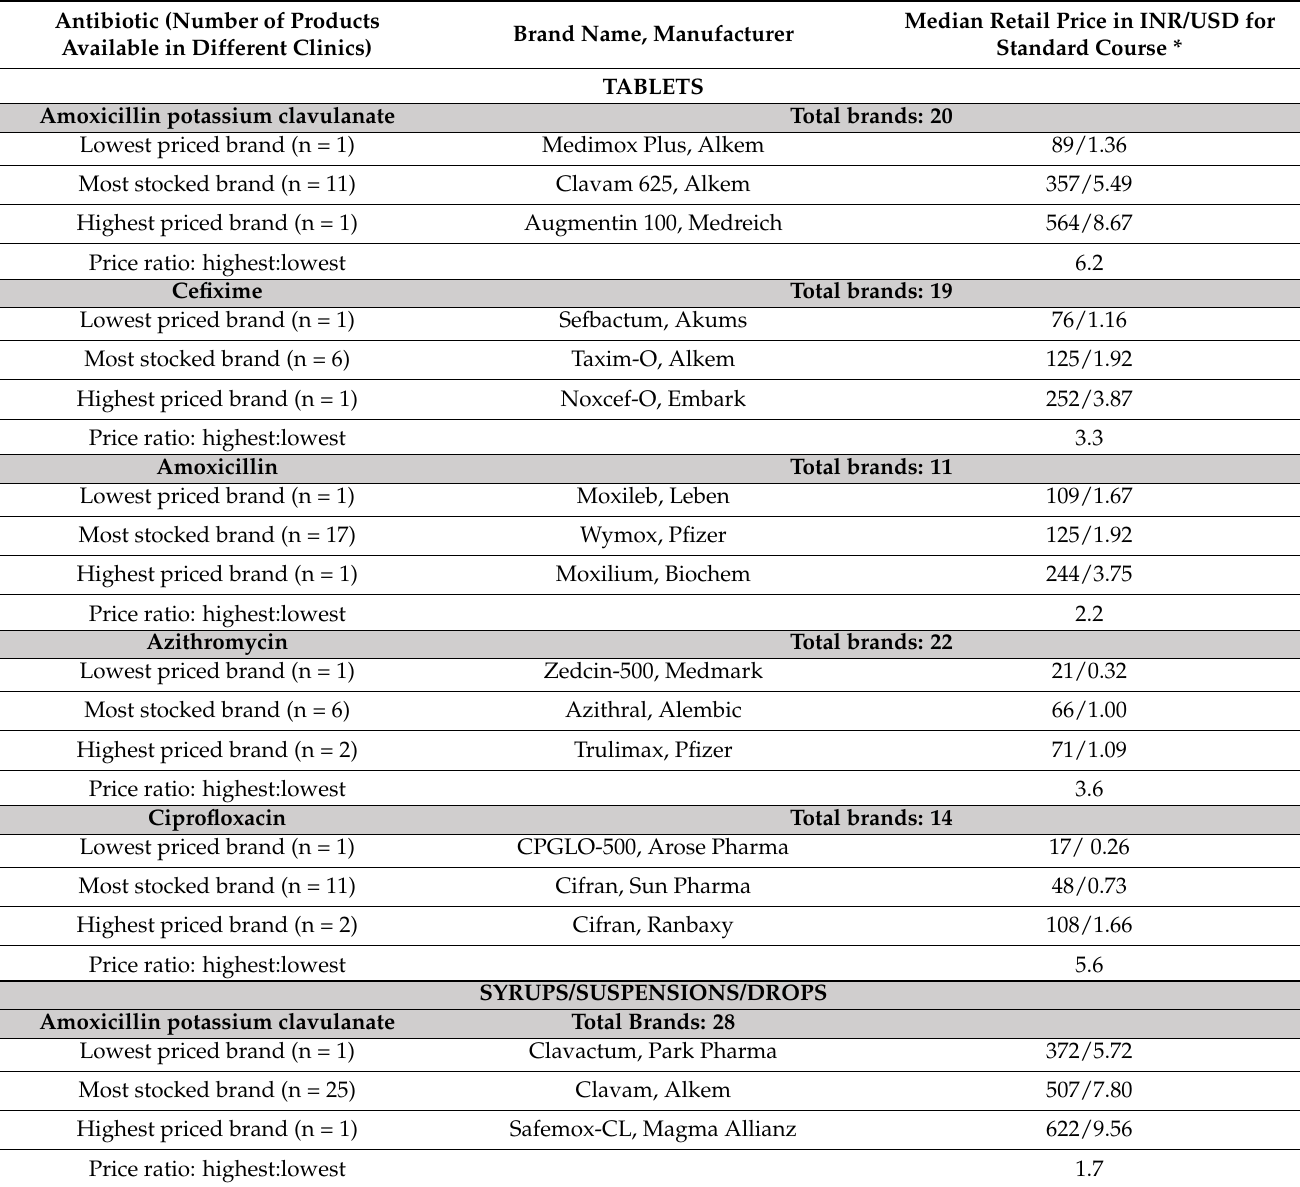
Table 4. Median prices of standard courses of treatment for the top 5 antibiotics, across different